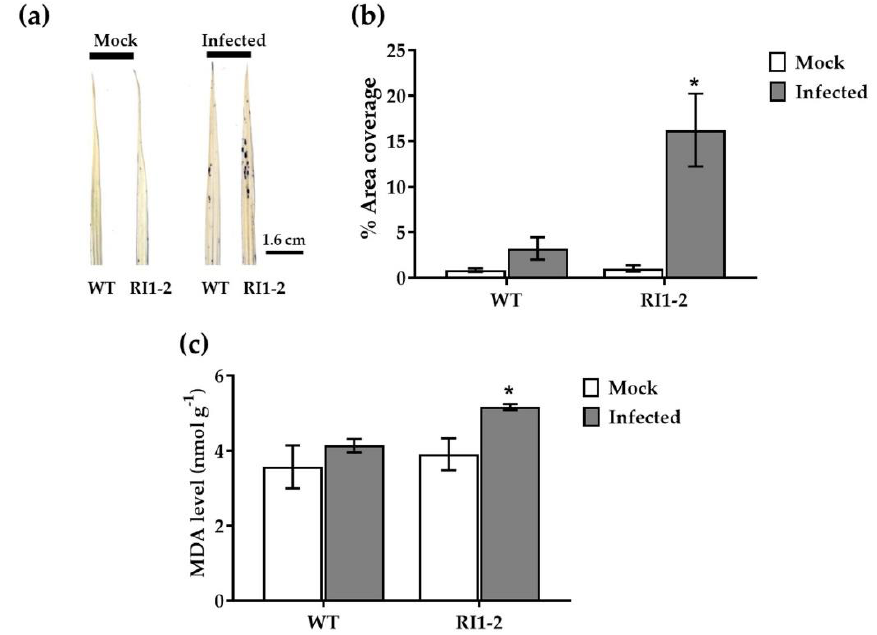
Figure 5. OsVTC1-1 RNAi (RI1-2) line induces accumulation of superoxide anion and lipid per- oxidation at 24 hpi with 10100 isolate. ( a ) Visualization of O 2 − detected by nitroblue tetrazolium (NBT) staining; ( b ) the percentage of the leaf area covered by O 2 − accumulation; ( c ) determination of lipid peroxidation by MDA measurement. Data are presented as the mean ± standard error of three replicates. Asterisk indicates statistically significant differences between mock and infected plants for each rice lines analyzed using Student’s t -test (* p <